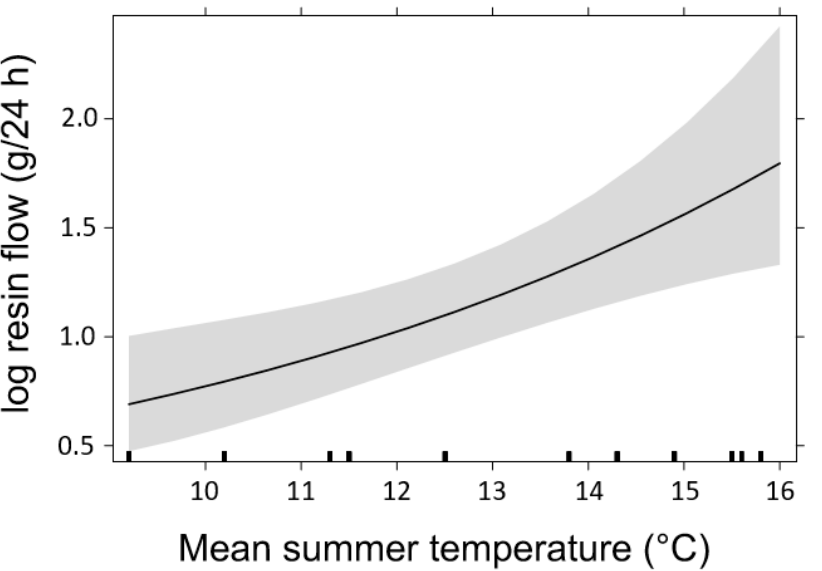
Figure 4. Relationship between resin flow and mean summer temperatures. The shaded area indi- cates the 95 % confidence band. The rug plot at the bottom of the graph shows the values meas- ured in this study. Statistical details are given in Table S1.